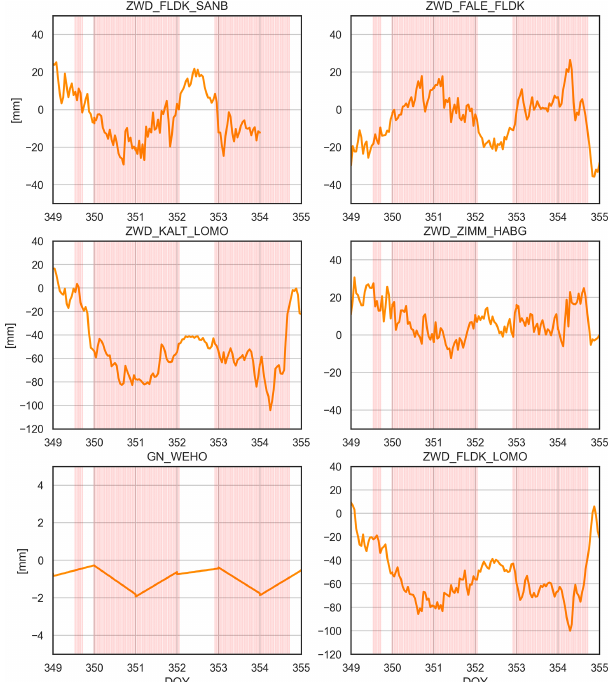
Figure 7. Time series of meteorological observations ( a : temper- ature (red) and relative humidity (green), (b) : wind speed (black) and direction (grey)); (c) : classification results of SVC (blue) and GB (orange) and the reference FI index (red)